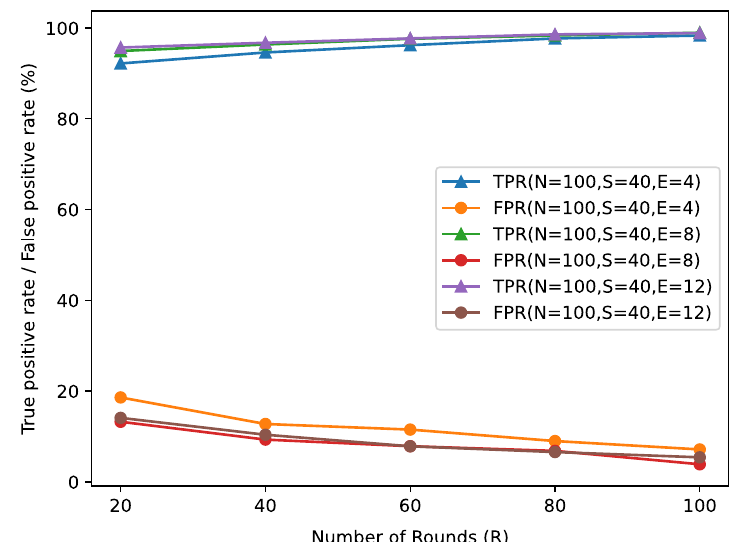
Fig. 6 Effects of the number of edge nodes C on detection performance